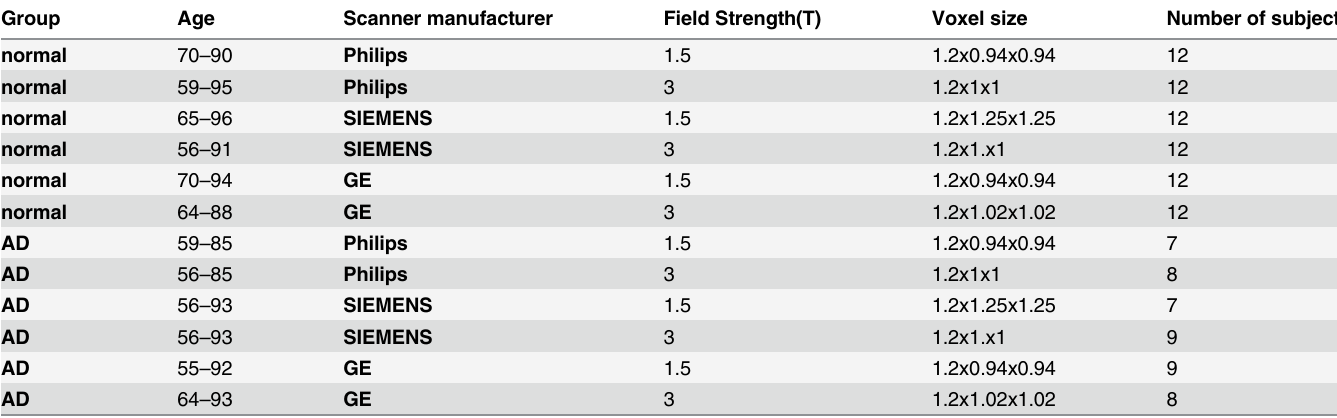
Table 1. Imaging parameters of the six